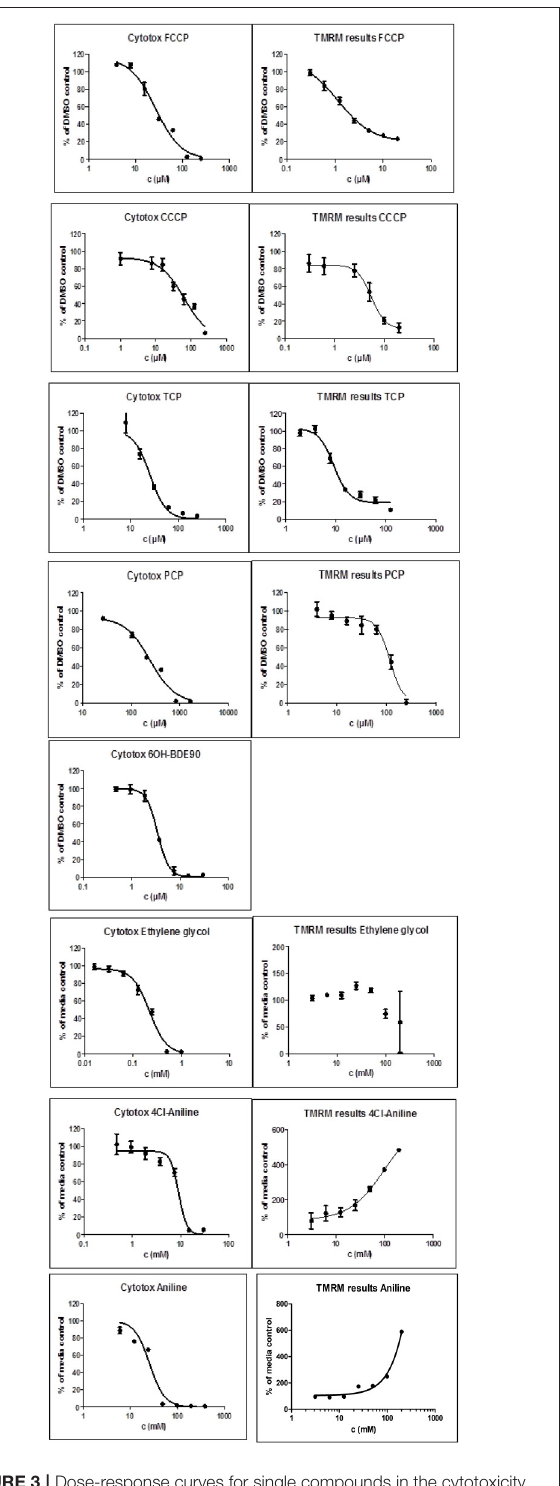
FIGURE 3 | Dose-response curves for single compounds in the cytotoxicity assay (Left) and the TMRM assay (Right) . For each experiment six wells per test concentration were averaged and each experiment was repeated three times. Data points present the mean over all measurements and the bars the standard deviation. TMRM graphs for Aniline and Cl-aniline where ambiguous, instead of a decrease an increase of the TMRM signal could be observed. 6OH-BDE90 was not measured in the TMRM